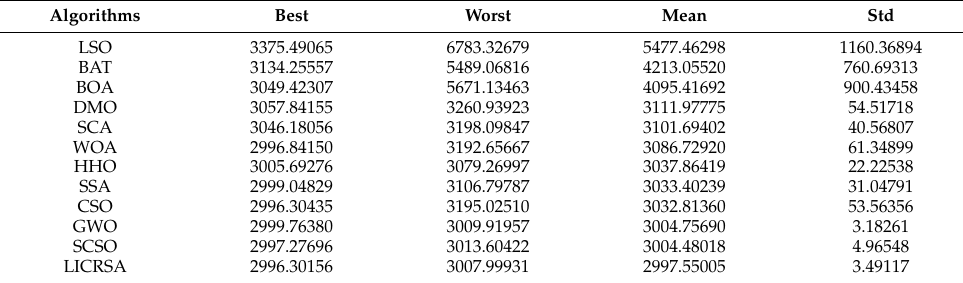
Table 20. Statistics of 20 independent operations of speed reducer